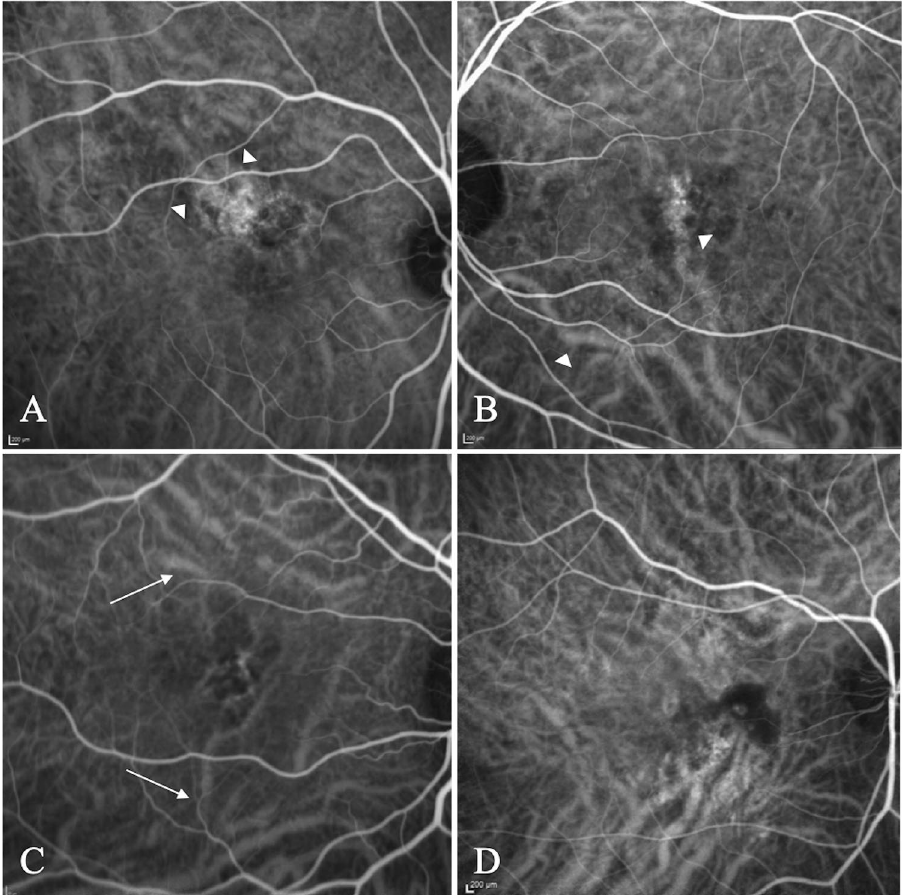
Figure 1. Exemplar early-phase ICGA images showing posterior pole pachyvessels in patients diagnosed with MNV secondary to pachychoroid disease. Abnormally dilated choroidal vessels can be preferentially localized in a half of the macula ( A superior intervortex veins are dominant compared to the inferior ones, B inferior vortex veins are dominant compared to the superior ones) or diffusely distributed over the whole macula ( C spaced pattern, D dense pattern). The normal horizontal watershed zone has disappeared showing instead collateral veins due to anastomoses between the superior and inferior vortex veins. The pachyvessels typically do not taper towards the macula and display abrupt, club-shaped posterior